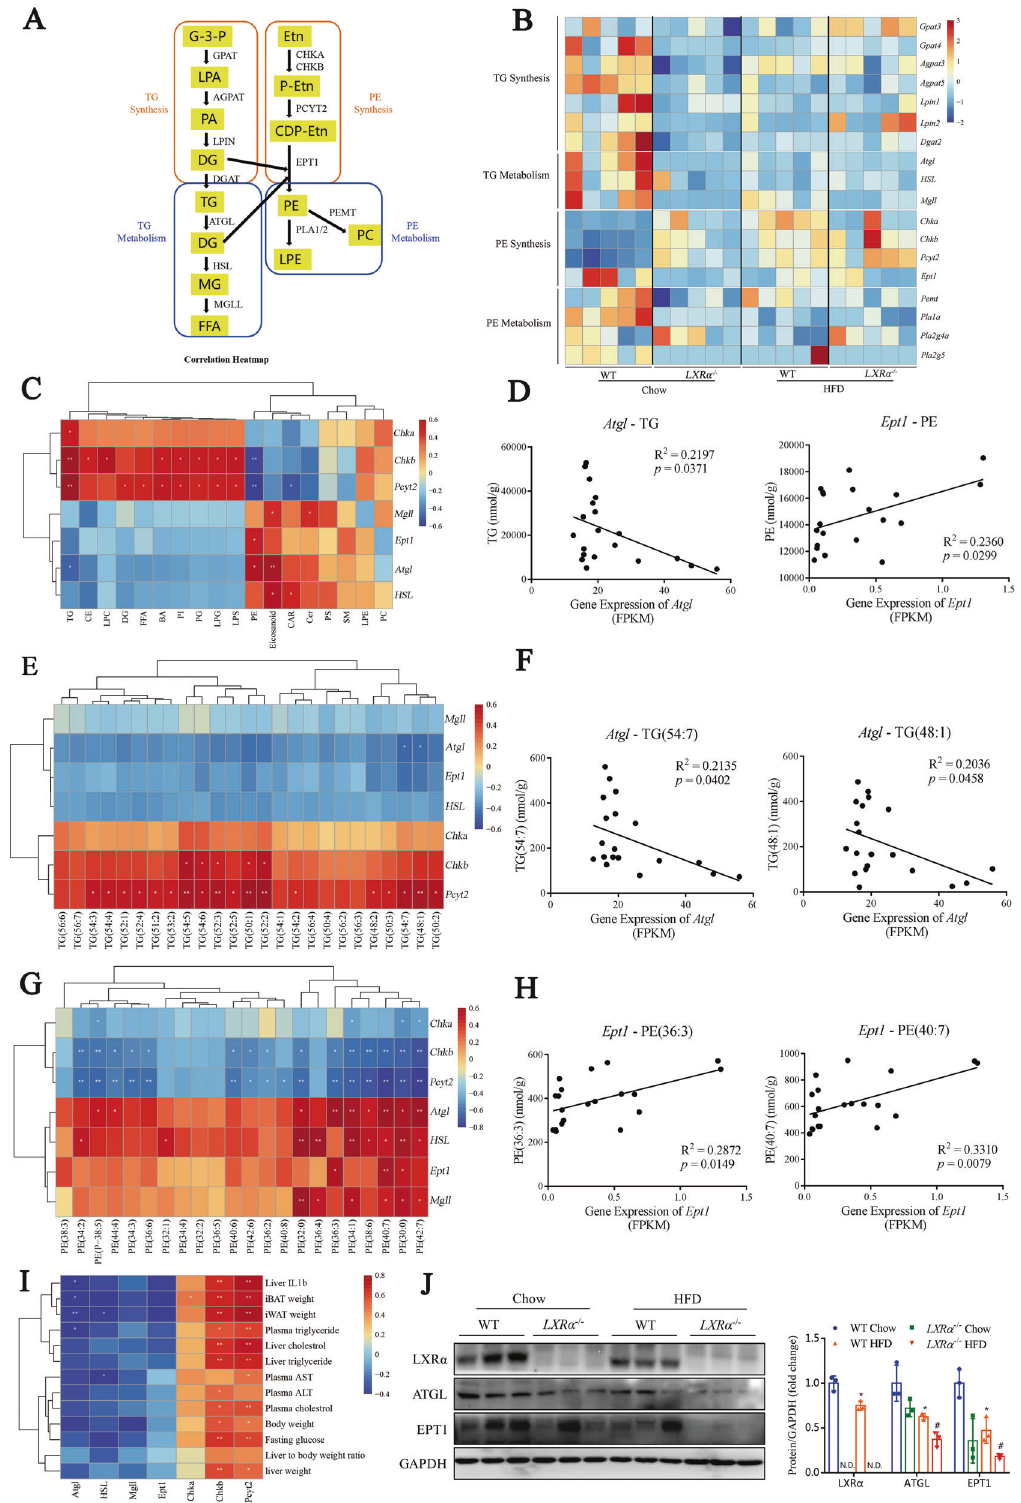
and saw a continuous drop in the LXR α − / − HFD (Fig. 3E, F). According to the correlation analysis between the lipid metabo- lites and the mice phenotypes, we observed that total TGs which were enriched in HFD-fed mice were positively correlated while total PEs, which were cut down in HFD-fed mice, were negatively